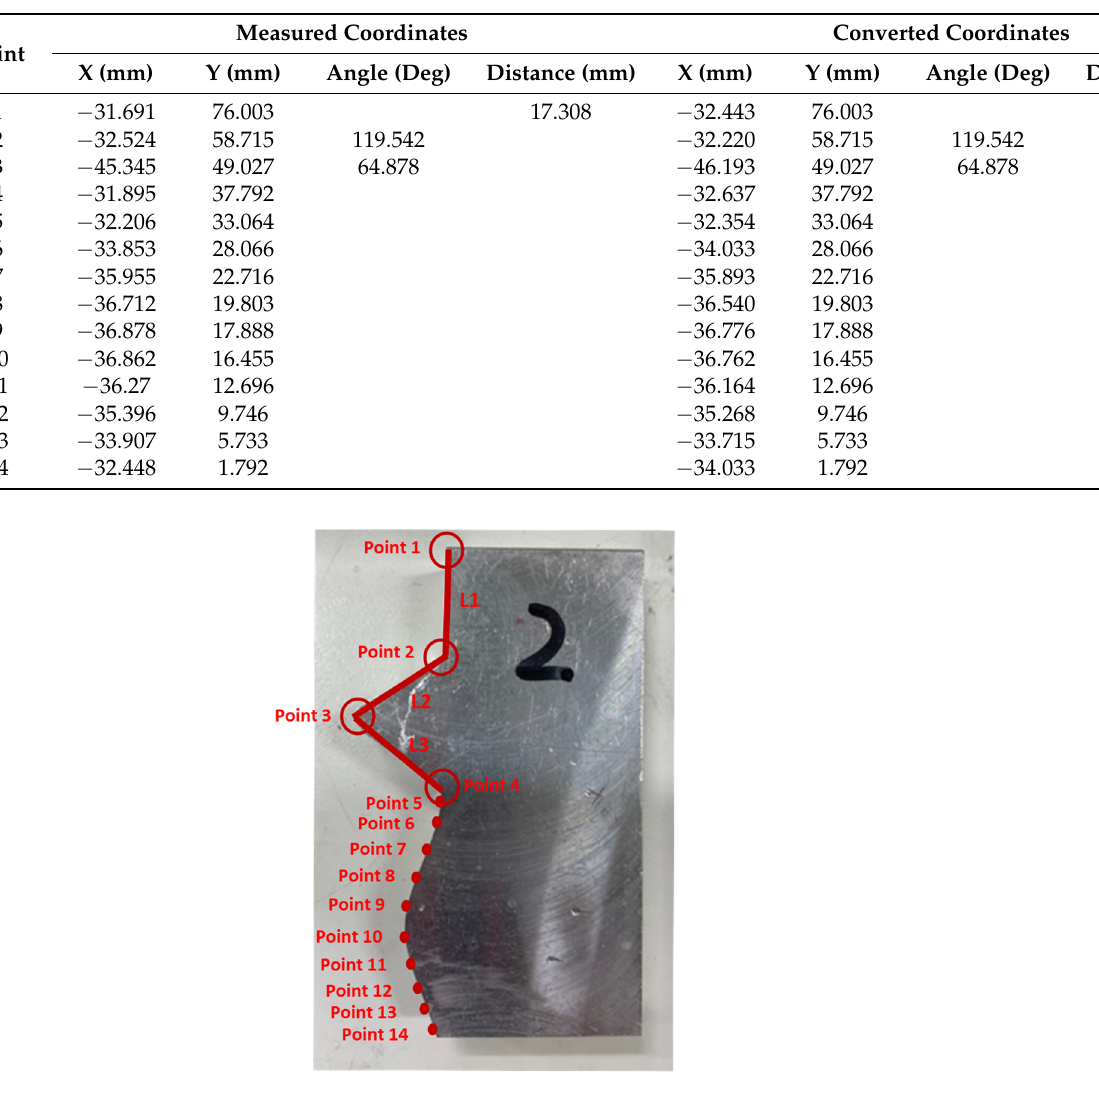
Figure 17. The finished complex counterpart with compensation. Table 7. The measured coordinates and conversion coordinates of complex counterpart with compensation.